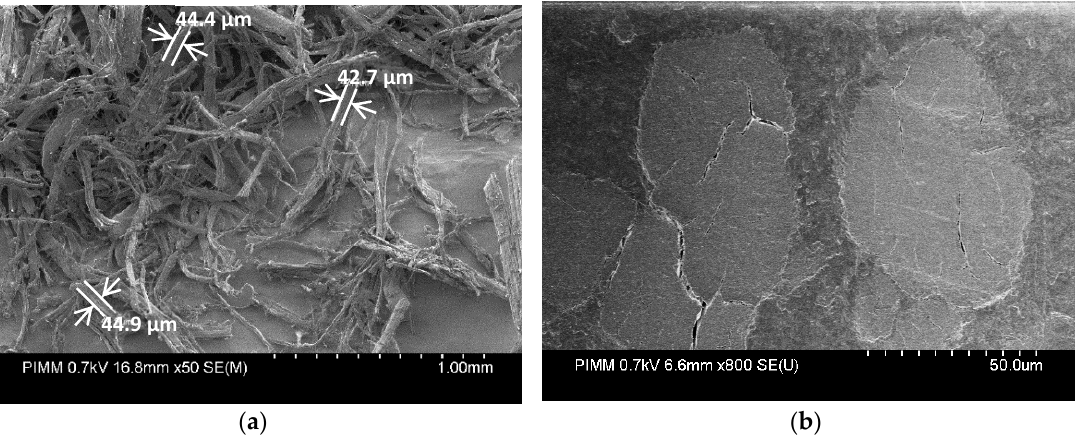
Figure 1. Scanning electron microscope images of hemp fibers ( a ) before mixing with the polymer matrix and ( b ) in an injected biocomposite sample.